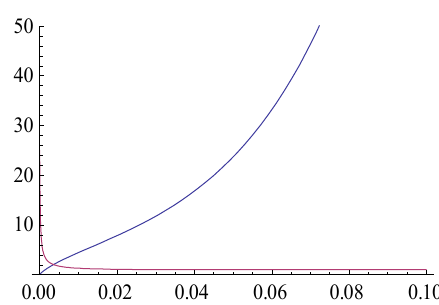
Figure 1. Model of behavior of the functions ( ) a t and ( ) С t  at small values of time t .